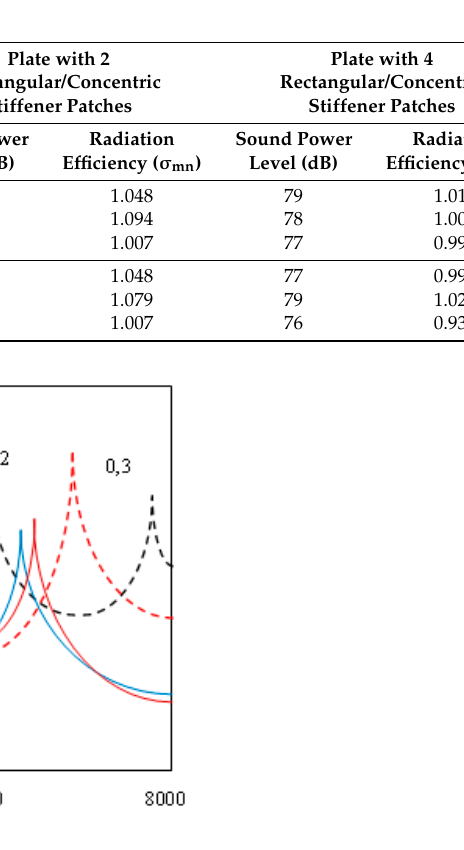
Figure 16. Numerical comparison of sound power level for annular plate having parabolic decreasing thickness variation (case I) for different attachments of rectangular stiffener patches for taper ratio T x = 0.75.